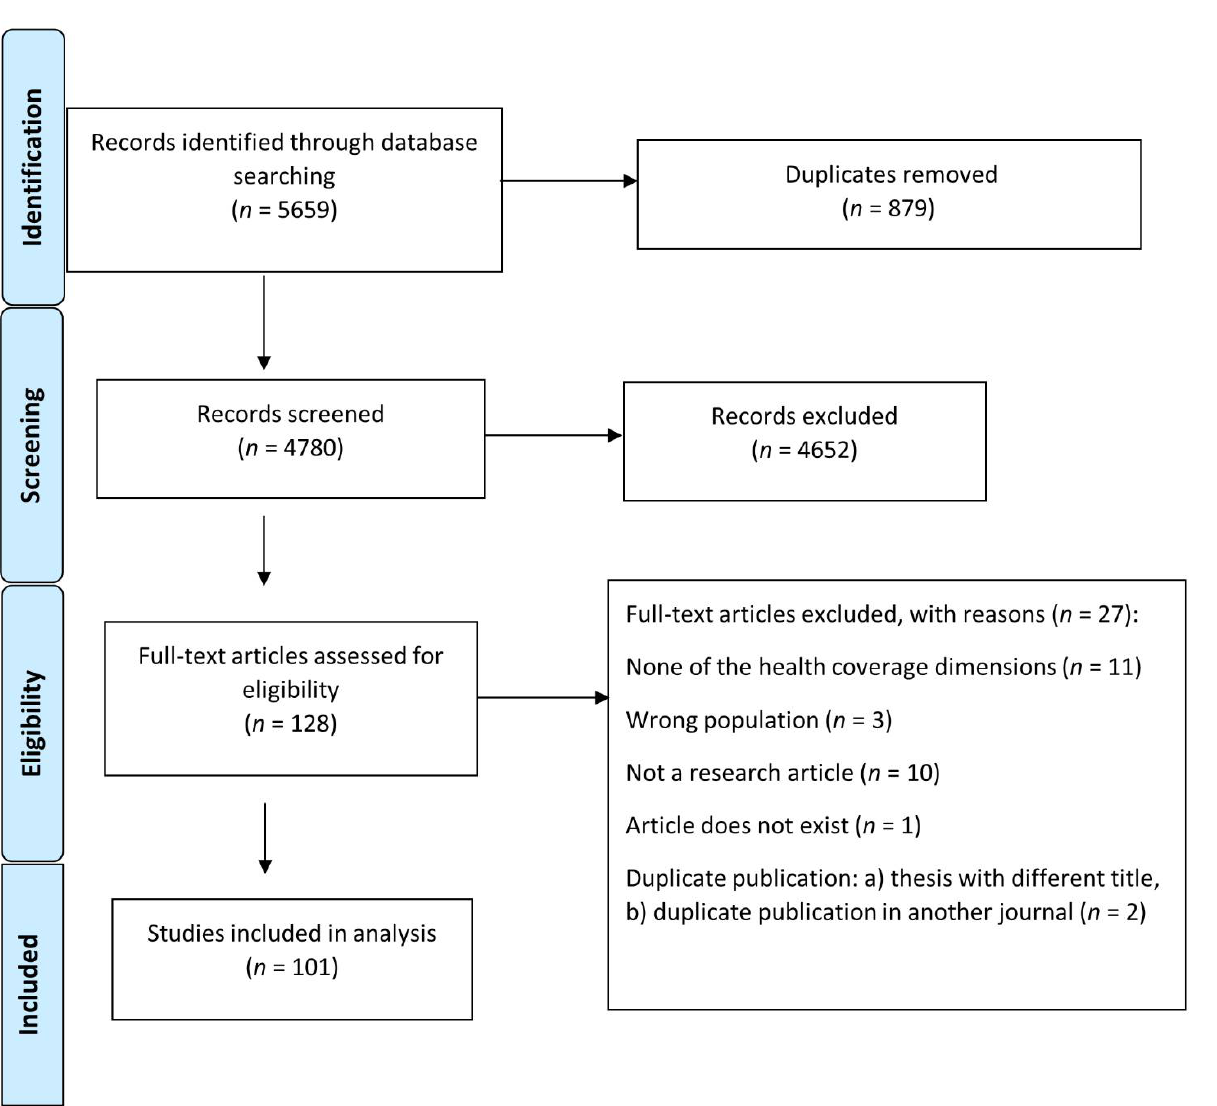
Figure 1. PRISMA flow diagram. Numbers of sources of evidence screened, assessed for eligibility and included in the